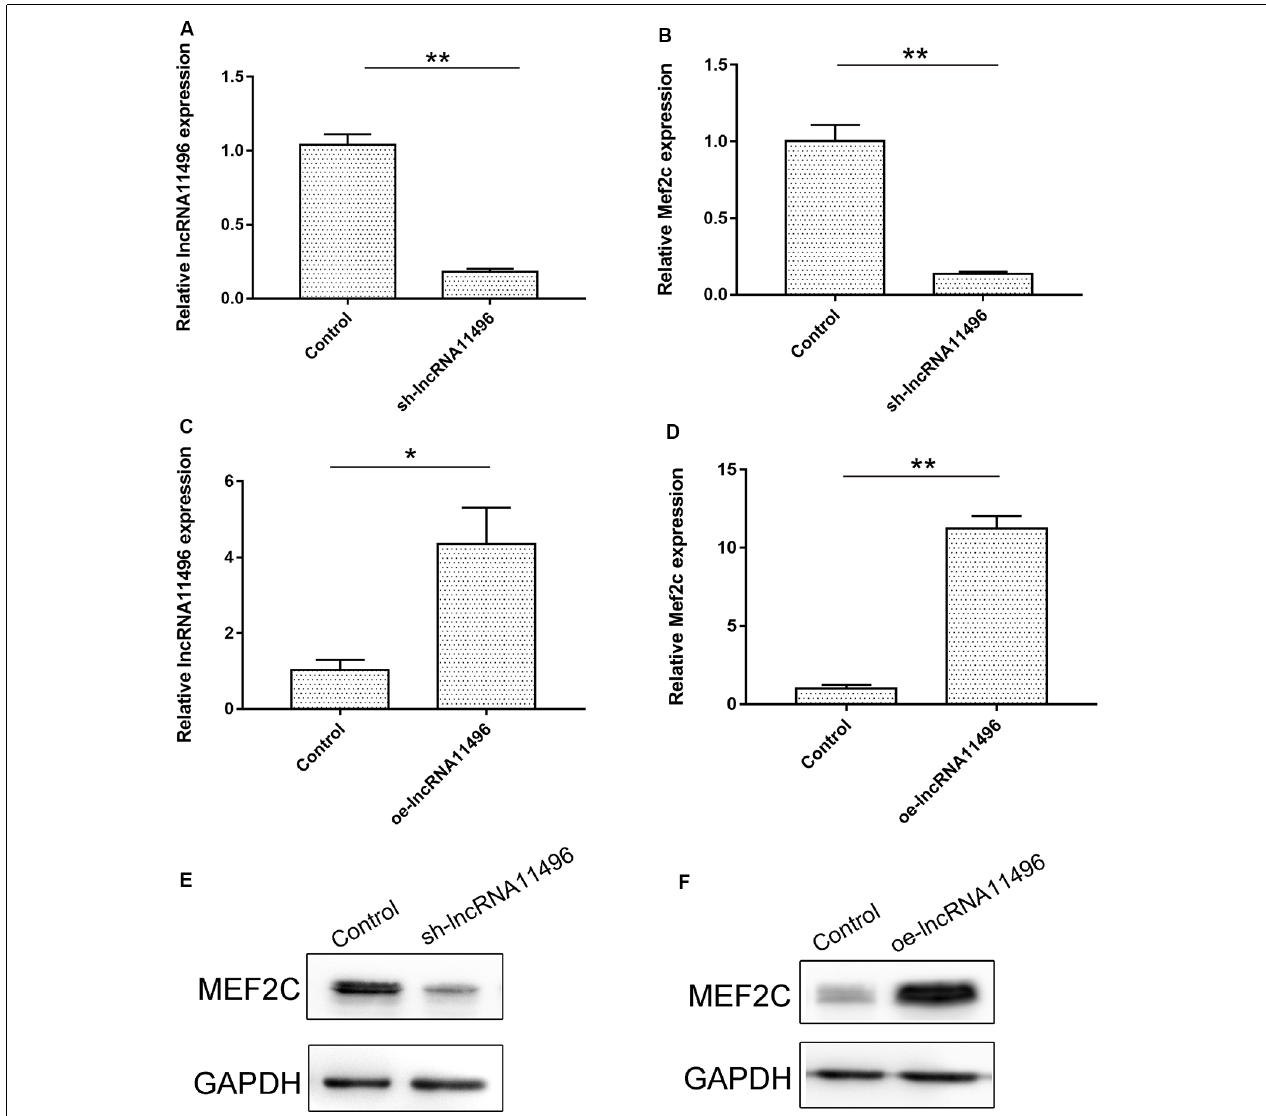
FIGURE 5 | lncRNA11496 positively regulates the expression of Mef2c. (A) The expression of lncRNA11496 in BV-2 cells transfected with shlncRNA-11496 was tested by qRT-PCR. All values are presented as mean ± SD for three independent experiments (** P < 0.01, student’s t -test). (B) The expression of Mef2c in BV-2 cells transfected with shlncRNA-11496 was tested by qRT-PCR. All values are presented as mean ± SD for three independent experiments (** P < 0.01, student’s t -test). (C) The expression of lncRNA11496 in BV-2 cells transfected with oe-lncRNA11496 was tested by qRT-PCR. All values are presented as mean ± SD for three independent experiments (* P < 0.05, student’s t -test). (D) The expression of Mef2c in BV-2 cells transfected with oe-lncRNA11496 was tested by qRT-PCR. All values are presented as mean ± SD for three independent experiments (** P < 0.01, student’s t -test). (E) The expression level of MEF2C protein was decreased in BV-2 cells transfected with shlncRNA-11496 was tested by Western-blot. GAPDH was used as an internal control. (F) The expression level of MEF2C protein was enhanced in BV-2 cells transfected with oe-lncRNA11496 was tested by Western-blot. GAPDH was used as an internal reference